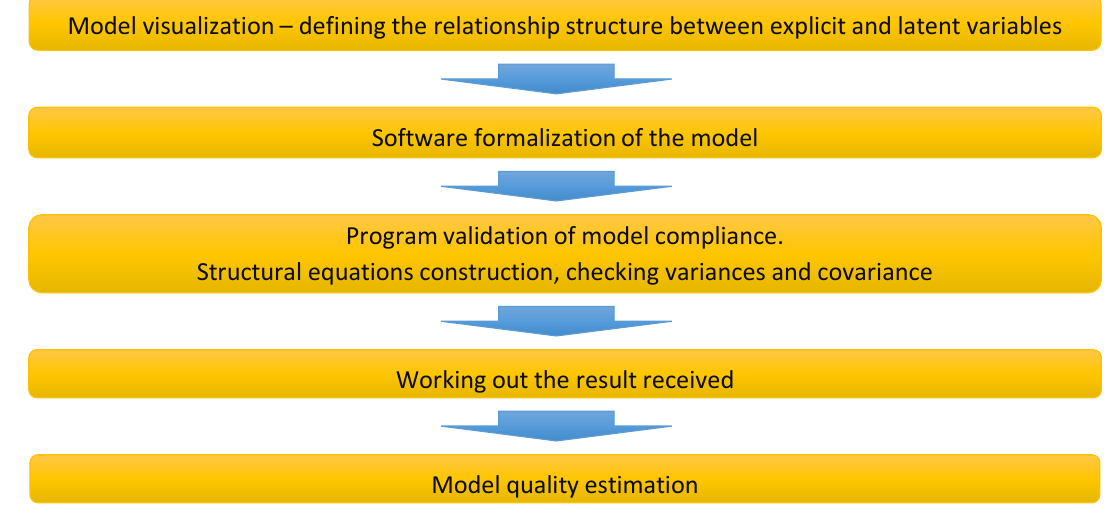
Figure 1. The structural modeling